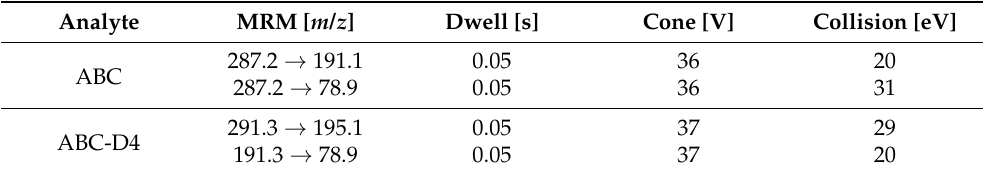
Table 1. Multiple reaction monitoring (MRM) transitions monitored ( m / z ) with cone and collision energy. Analyte MRM [ m / z ] Dwell [s] Cone [V] Collision [eV] 287.2 → ABC